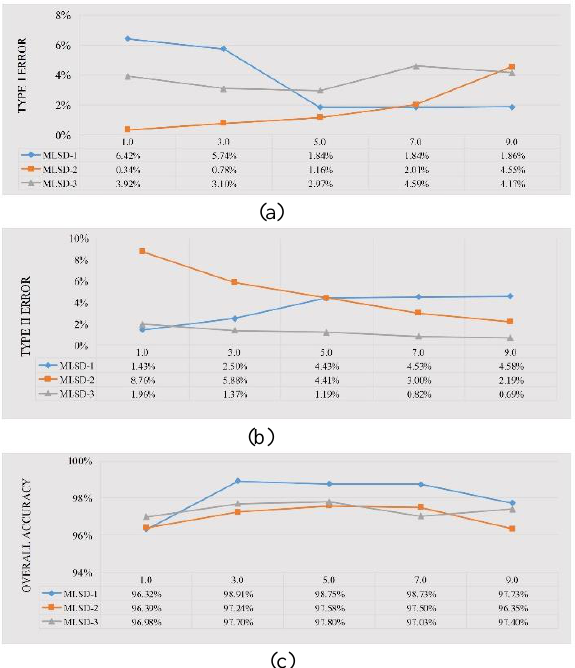
Fig.4 Sensitivity tests with the size of 2-D block ( Γ b ): (a) Type I error, (b) Type II error, and (c) Overall accuracy Next, we used Γ b = 5.0 m ， h g = 0.5 m ， and h e = 4.5 m, and